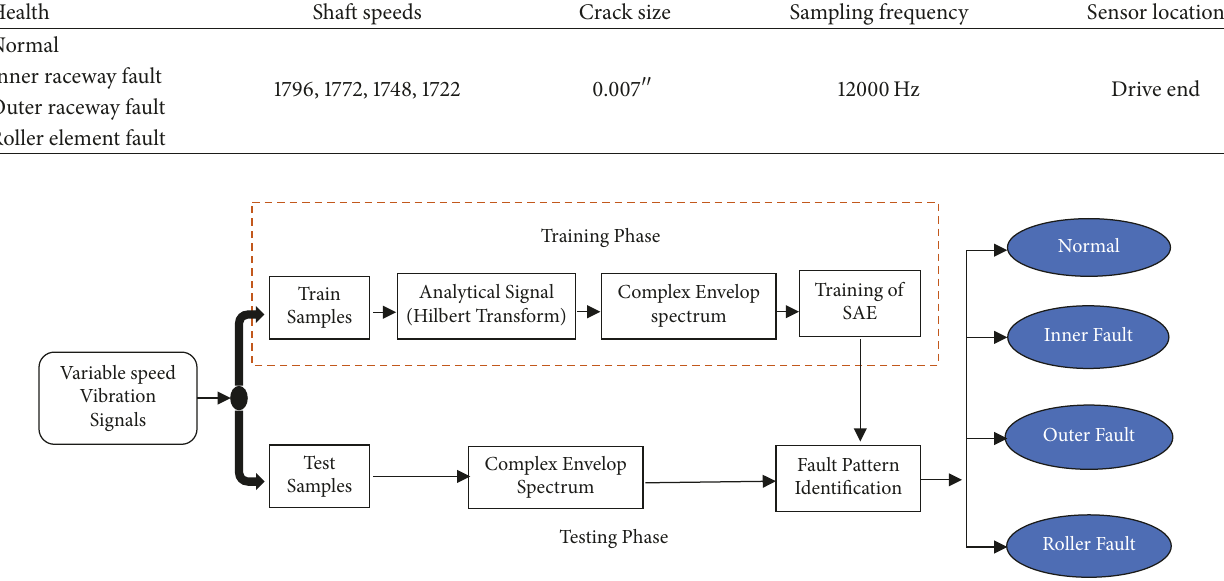
Table 1: Description of the datasets used in the proposed scheme.